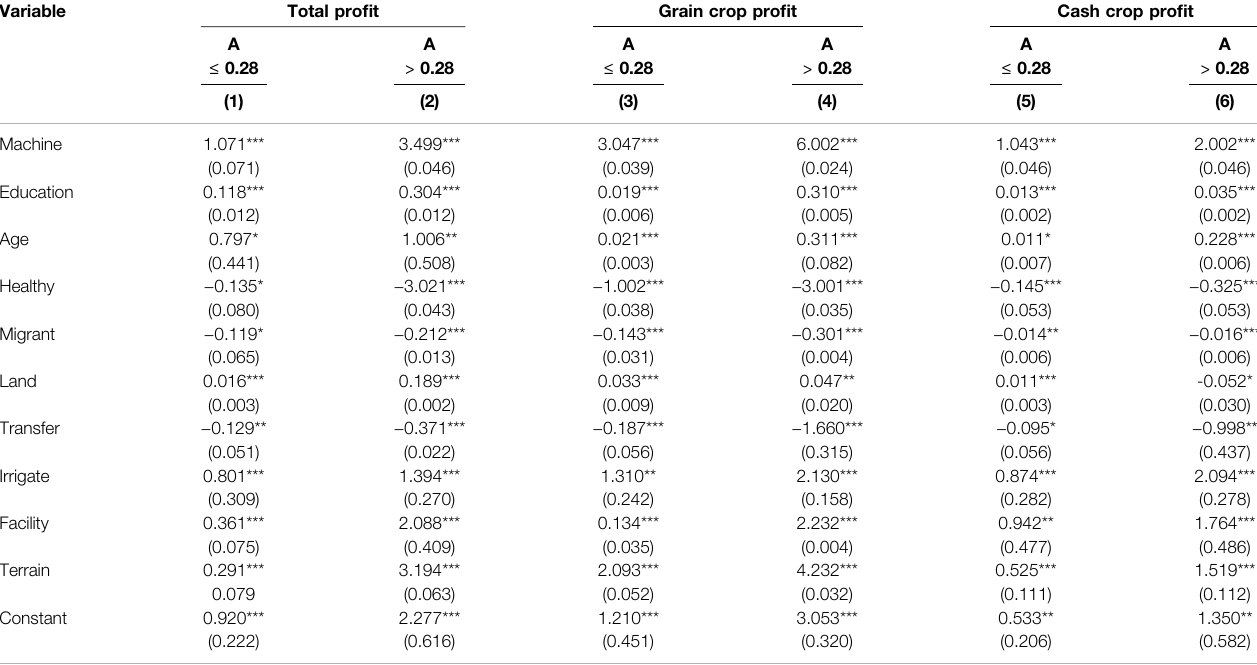
TABLE 7 | Estimation of the threshold effect of agricultural mechanization level on agricultural pro fi t. Variable